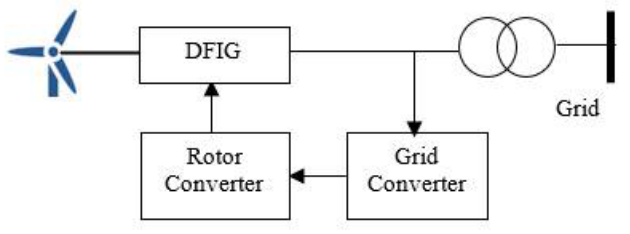
Figure 4. Type 3 wind turbine and farm.